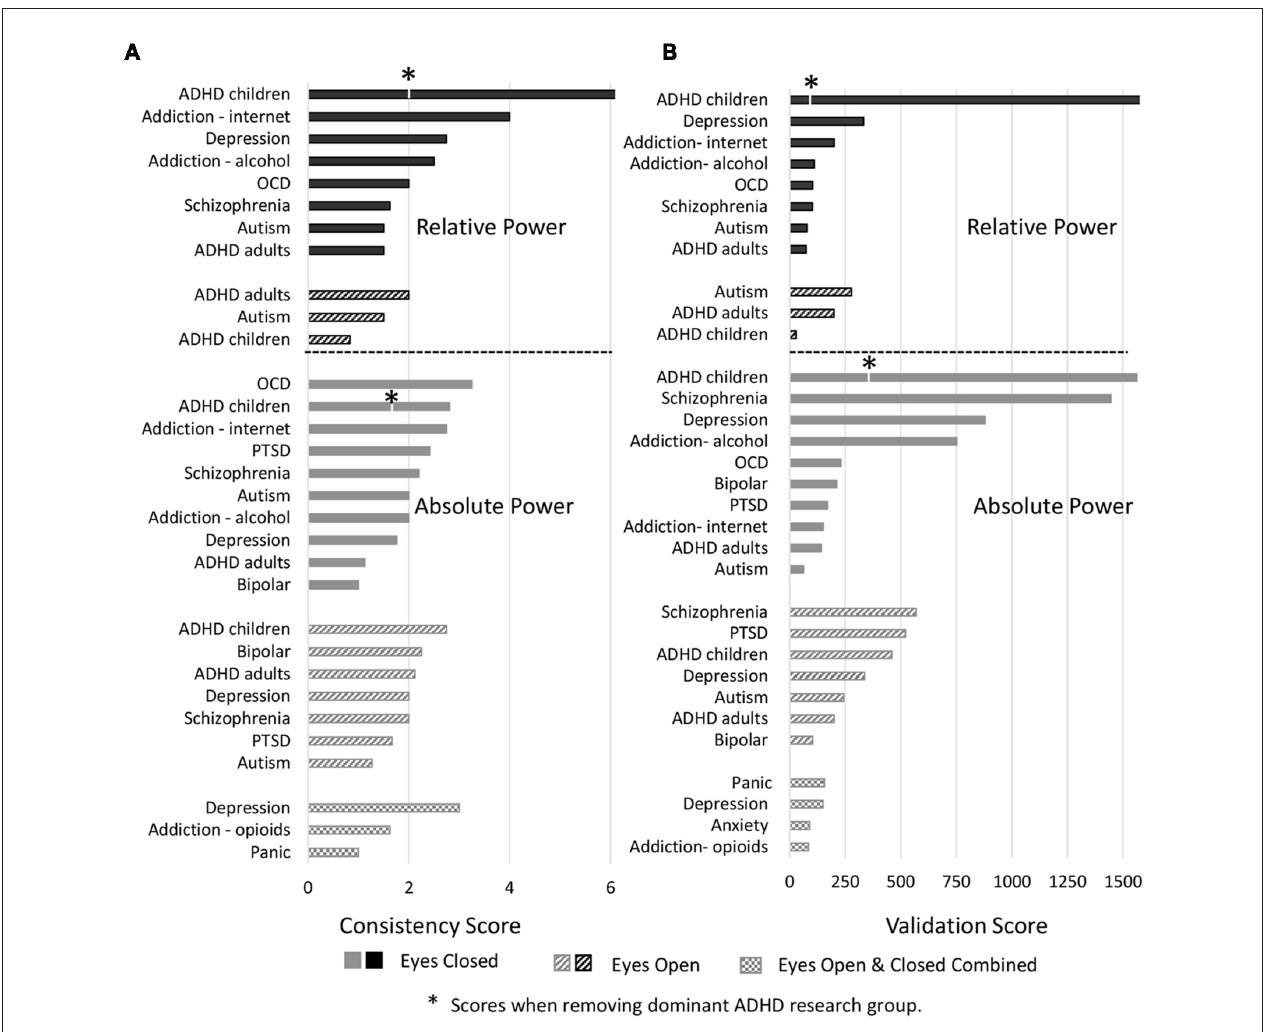
FIGURE 5 | Consistency and validation scores by disorders. (A) Consistency scores for each disorder for relative power (top) with eyes closed (black bars) and eyes open (black hashed bars) and absolute power (bottom) with eyes closed (gray bars), eyes open (gray hashed bars) and eyes closed and open combined (hatched bars). Asterisk marks for attention deficit-hyperactivity disorder (ADHD) indicate consistency scores when the dominant research group is excluded. (B) Validation scores for each disorder. Order and legend are as in (A) . Validation score for ADHD in children, relative power with eyes closed goes beyond the scale of this graph